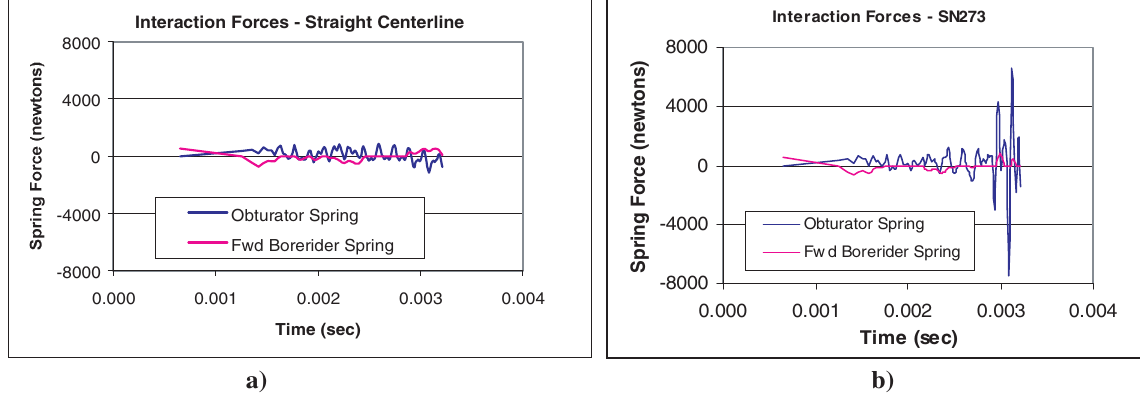
Fig. 8. Interaction